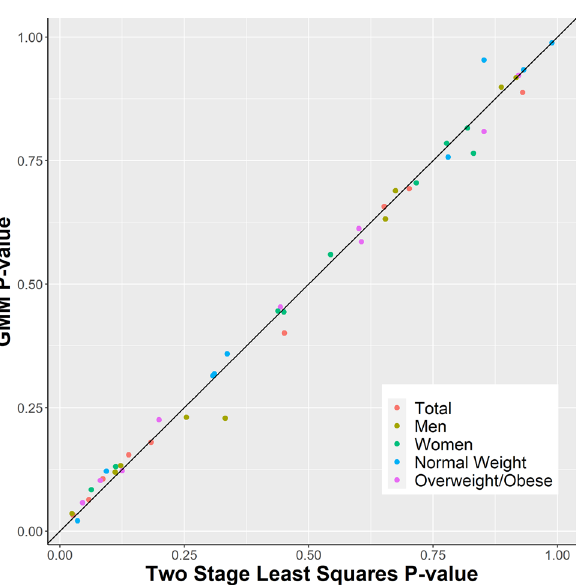
Figure 5. Causal associations between adiponectin and cardiometabolic outcomes in men and women using the two-stage least-squares method. Values are presented are adjusted for age, population stratification, BMI, alcohol consumption, and smoking. SBP and DBP are additionally adjusted for blood pressure medication use. HOMA-IR and Triglycerides were log transformed. All continuous variables were Z-standardized. T2D cases were excluded for all HOMA-IR analyses.